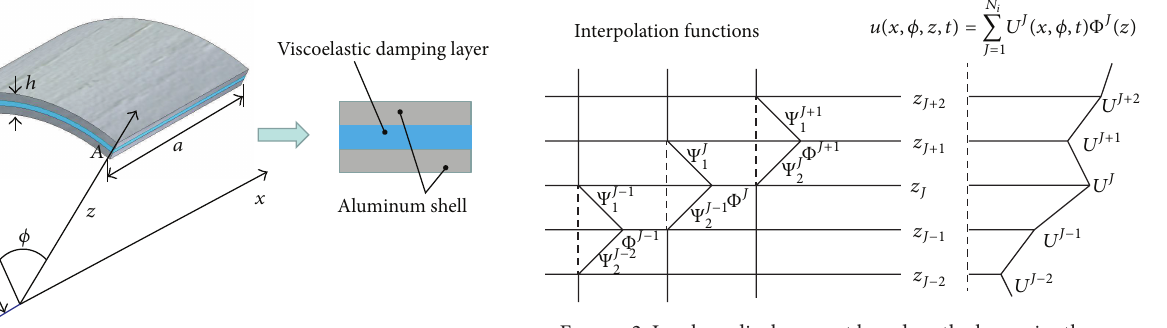
Figure 1: Geometry of cylindrical aluminum shell with viscoelastic damping layer.